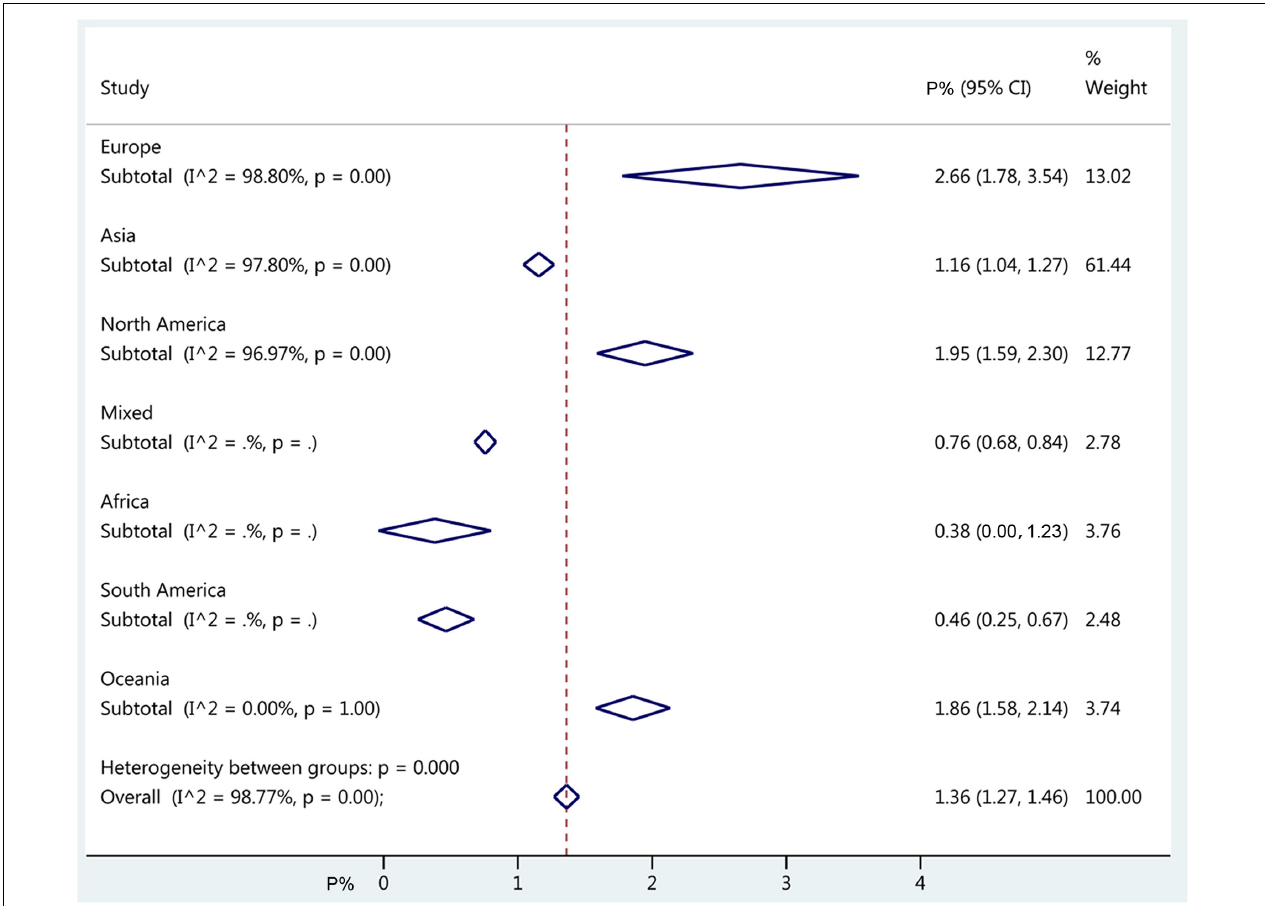
FIGURE 3 | Forest plot of pooled continent prevalence of amblyopia. The diamonds represent the prevalence estimates with 95% confidence intervals (CIs). The dashed red line represents the global estimate. The x -axis represents the prevalence of amblyopia, in%. “Mixed country” referred to studies that included countries from different